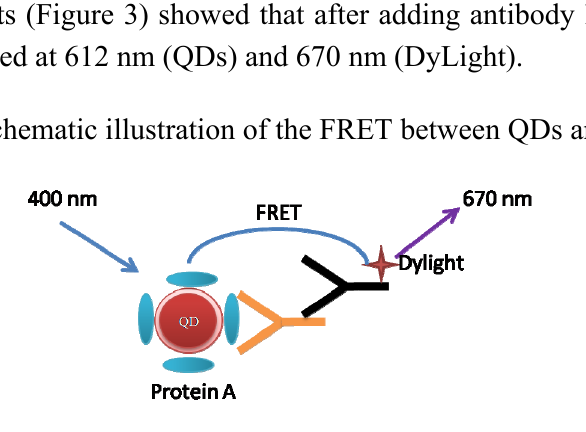
Figure 3. Electropherograms of QD-immunocomplex with detection in two different channels (black: 612 nm for QDs; red: 670 nm for DyLight). ( a ) 1 h immune reaction mixture; ( b ) 2 h immune reaction mixture; ( c ) 2 h immune reaction mixture after adding excess protein A for 1